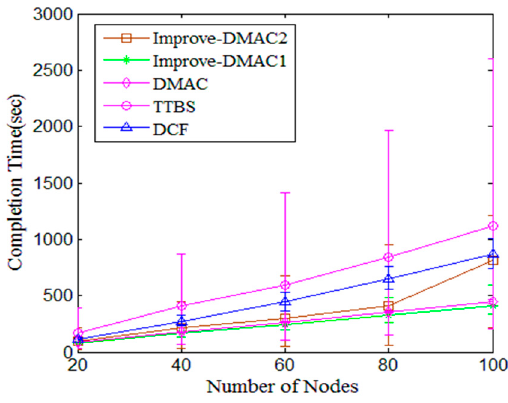
Figure 7. Transmission time under multi-rate scenario.